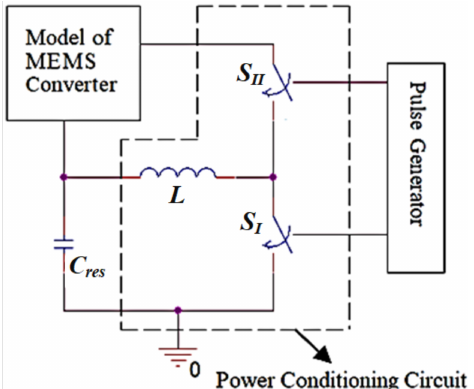
Figure 8. The block diagram for the vibration energy harvesting